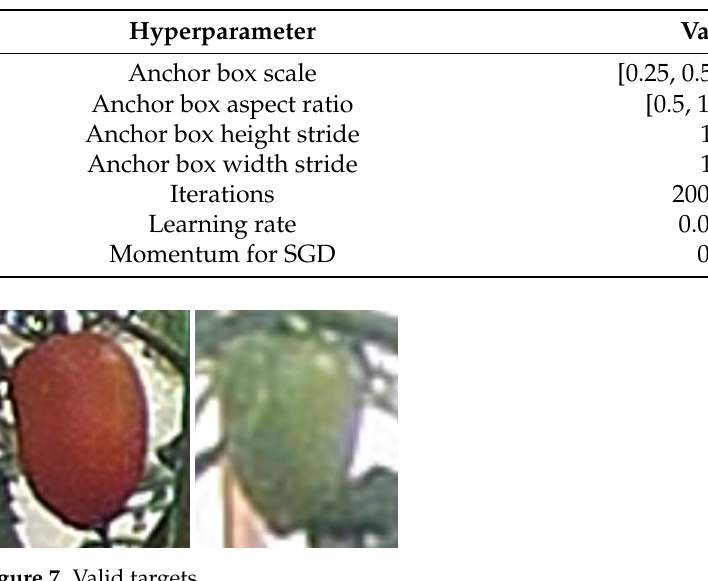
Table 2. Faster R-CNN hyperparameters.